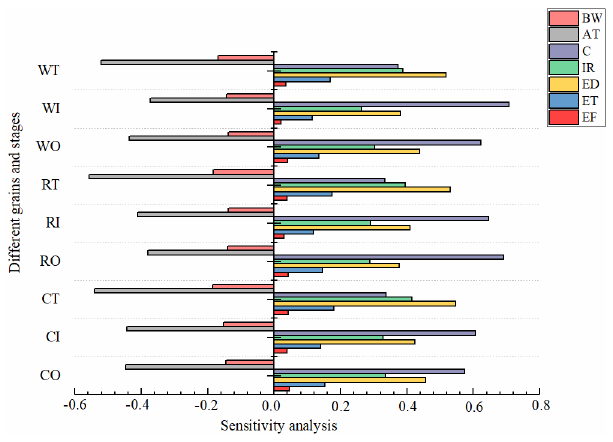
Figure 6. Sensitivity analysis at different stages for each grain.